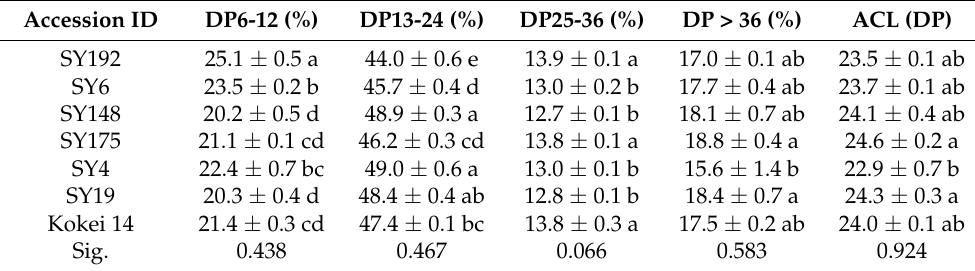
Table 3. Chain length distributions of isoamylase-debranched amylopectins from C-type starches of different sweet potato varieties.